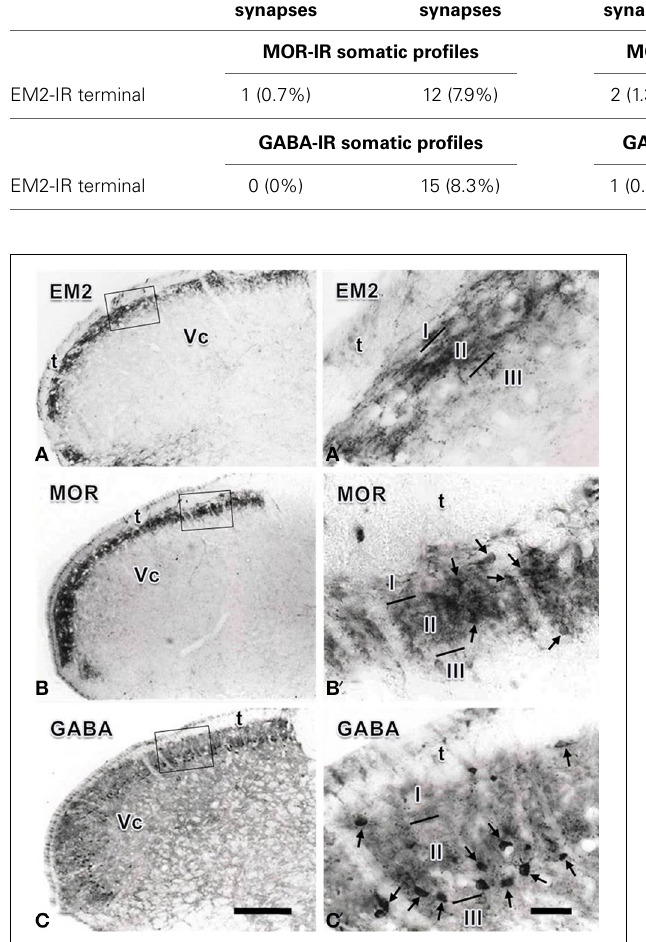
FIGURE 1 | Immunohistochemical staining showing the distributions of endomorphin-2 (EM2, A), μ -opioid receptor (MOR, B) and GABA (C) immunoreactive (IR) neuronal cell bodies and/or fibers and terminals in the spinal trigeminal caudal nucleus (Vc). The rectangle areas in (A–C) are enlarged in (A (cid:2) –C (cid:2) ) , respectively. Arrows in (B (cid:2) ,C (cid:2) ) point to MOR- and GABA-IR neuronal cell bodies, respectively. I, lamina I; II, lamina II; III, lamina III; t, spinal trigeminal tract. Scale bars = 320 μ m (in C and also for A and B ) and 60 μ m (in C (cid:2) and also for A (cid:2) and B (cid:2) ).